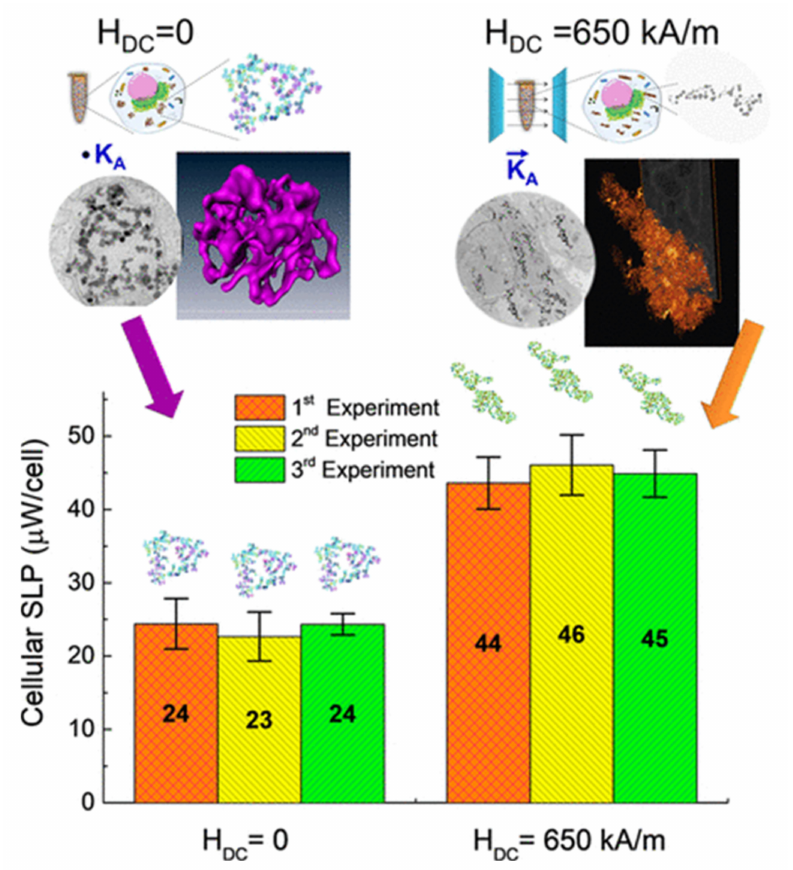
Figure 9. In vitro power absorption experiments for aggregates of MnFe 2 O 4 NPs within BV2 cells. The aggregates formed overnight without an applied field, resulting in sphere-like shape, and under an applied dc field H = 650 kA/m, resulting in elongated shape. SLP values are given per cell in µ W/cell. Adapted with permission from Ref. [218], Copyright 2020 American Chemical